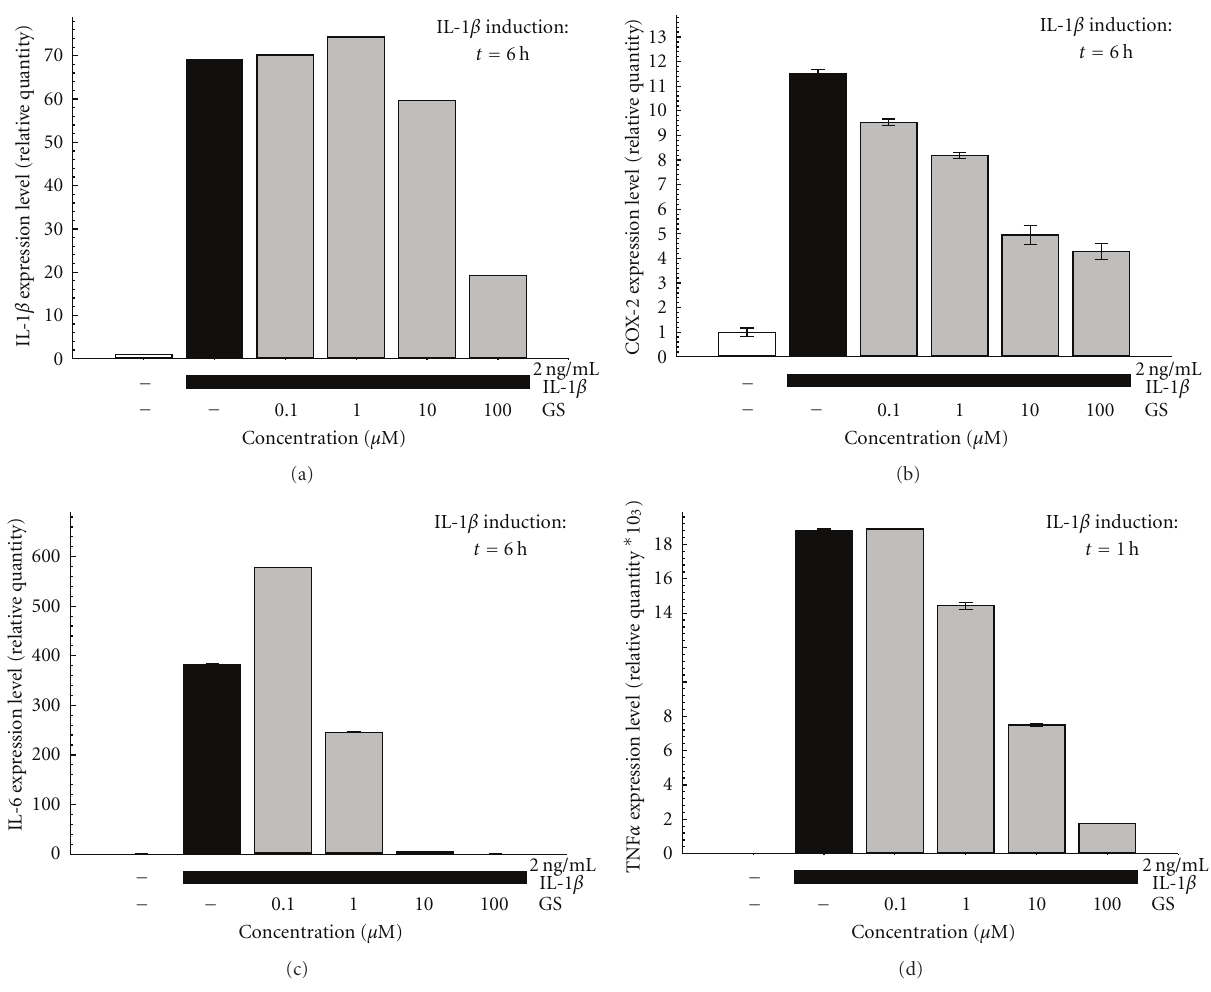
Figure 1: E ff ect of GS on IL-1 β -induced gene expression of IL-1 β (a), COX-2 (b), IL-6 (c), and TNF α (d). One hour after the pretreatment with GS (0,1–100 μ M), SW1353 are stimulated with IL-1 β (2ng/mL) as indicated. Representative pictures of 3 to 5 independent experiments are shown. Data are mean ± SD of three